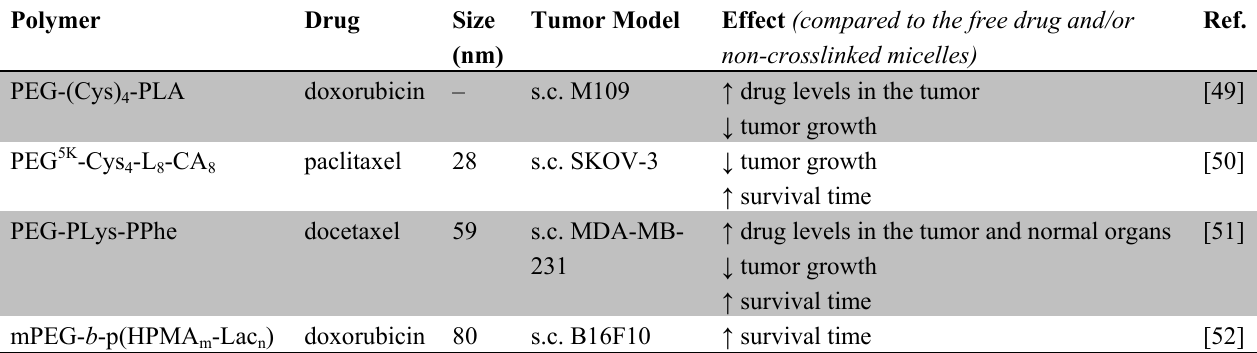
Table 3. Cross-linked micelles improve the stability and drug delivery efficiency.